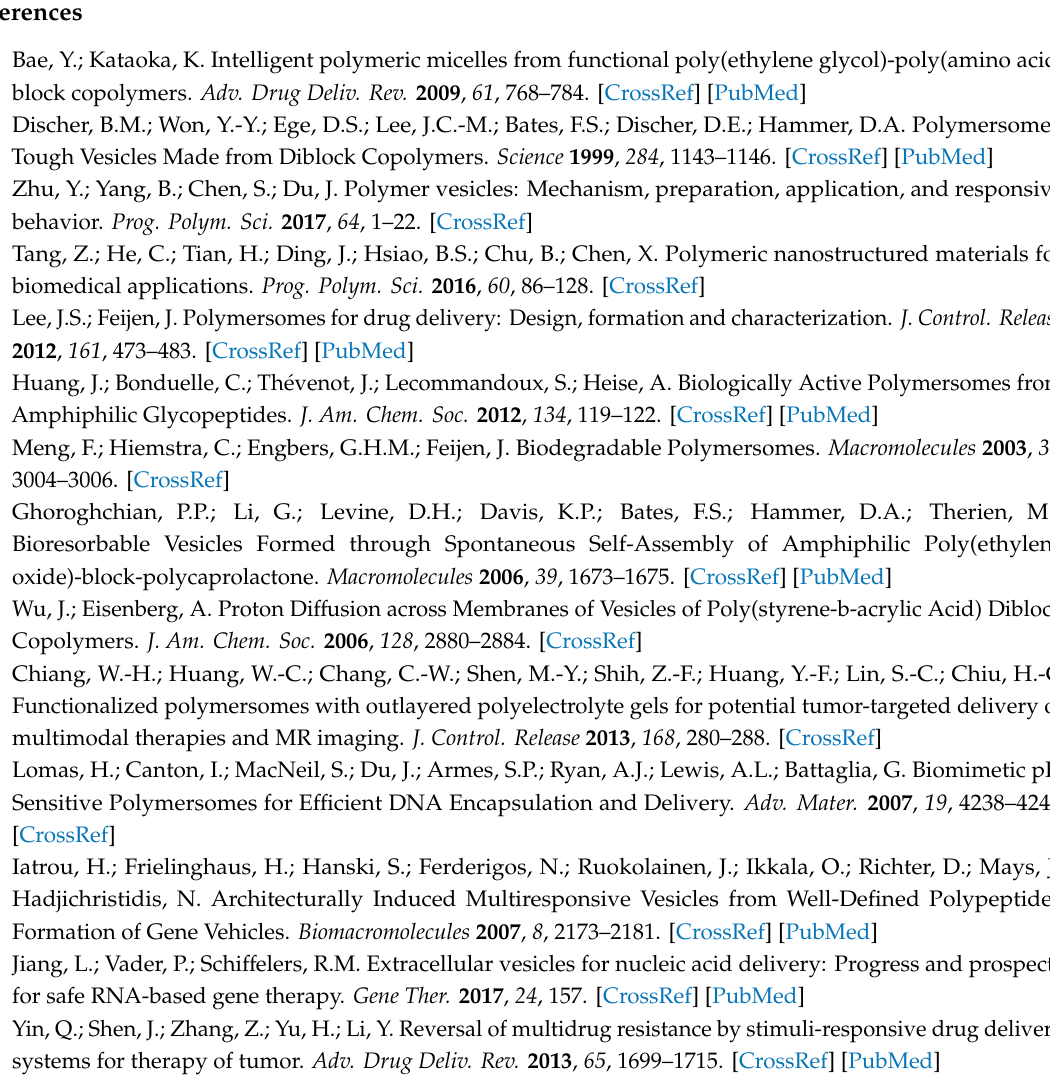
Figure S1. Synthetic routes of (A) NBEL, (B) thiol-terminated PMCL, and (C) photocleavable diblock copolymers 4 and 5 . Figure S2. GPC charts of photocleavable diblock copolymer (A) 4 and (B) 5 with RI detection. Figure S3. AF4 fractograms of polymersomes (A) 2 , (B) 3 , and (C) 5 . Figure S4. AF4 fractograms of (A) 1b , (B) 2 , (C) 3 , and (D) 5 at a low flow rate (0.2 mL min − 1 ). Figure S5. Structural characterization of the as-prepared polymersomes. Rg / Rh plots of (A) 2 , (B) 3 , and (C) 5 . Figure S6. 1 H NMR of 1b in CDCl3 (A) before irradiation, and after irradiation for (B) 2 min and (C) 10 min. Figure S7. Changes in the UV spectra of photocleavable diblock copolymer (A) 1b and (B) 4 upon photoirradiation in THF. The polymer solution (0.1 mM) was irradiated with near-UV light ( λ > 320 nm). Photolysis of the 2-nitrobenzyl ester was complete in 120 s, similar to the case of 2-nitrobenzylimide, because there were no further changes in the UV spectrum. Figure S8. Structural changes of polymersomes in response to photoirradiation. (A-C) DLS results of polymersomes (A) 3 and (B) 4 , irradiated for 0 ( (cid:4) ), 2 (gray, (cid:7) ), and 15 min ( ∆ ). Figure S9. AF4 fractograms of polymersome (A) 3 and (B) 5 after irradiation for 15 min. Table S1. Results of the payload releasing behaviors of entrapped fluorescein molecules from the polymersomes 1b (NBIL type) and 4 (NBEL type) in dark without